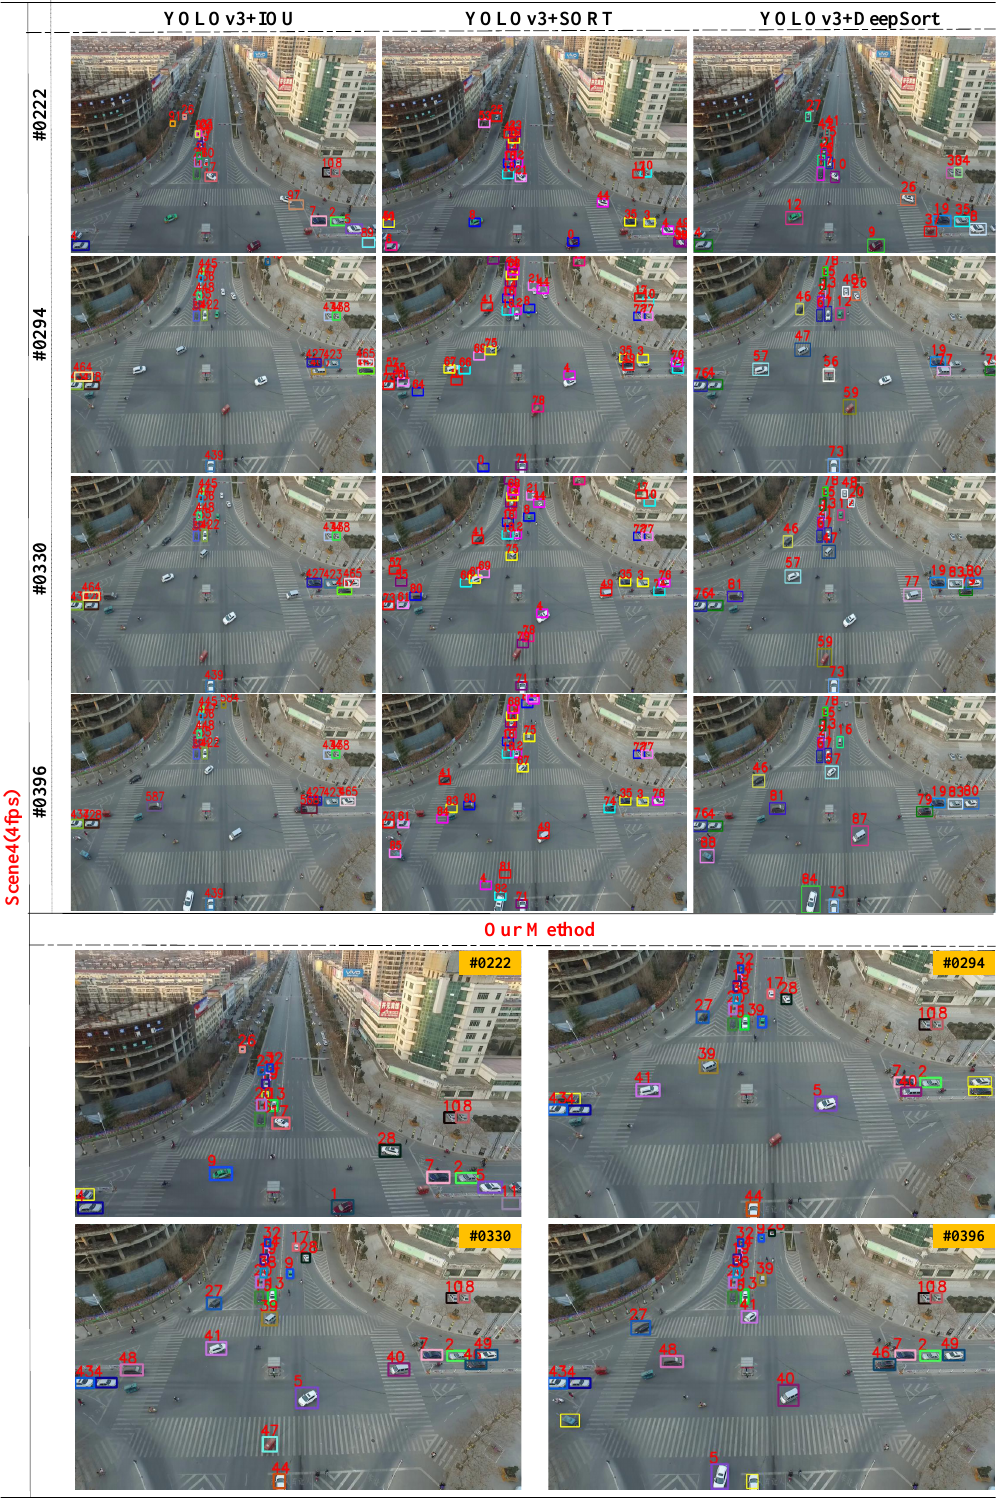
Figure 12. Tracking results of this algorithm and three other tracking algorithms in Scene 4, YOLOv3 + IOU, YOLOv3 + SORT, and YOLOv3 + DeepSort. Scene 4 was a crosroad, there were many vehicles in the scene, and the motion of the target was complicated. The video frame rate of the experimental images was 5